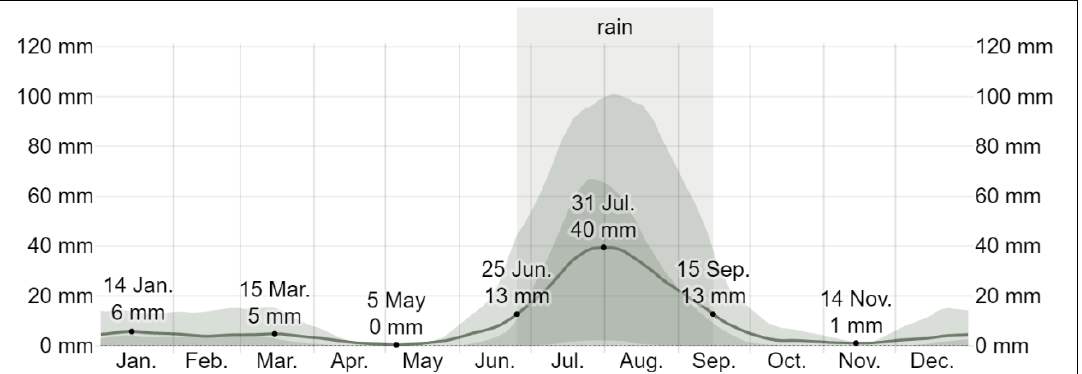
Figure 3. The average monthly mean (dark gray) and maximum (light gray area) and daily maximum (line with dots) rainfall in Karachi, 2014–2022 [44]. The rainy season (rain) from June to September is also indicated.